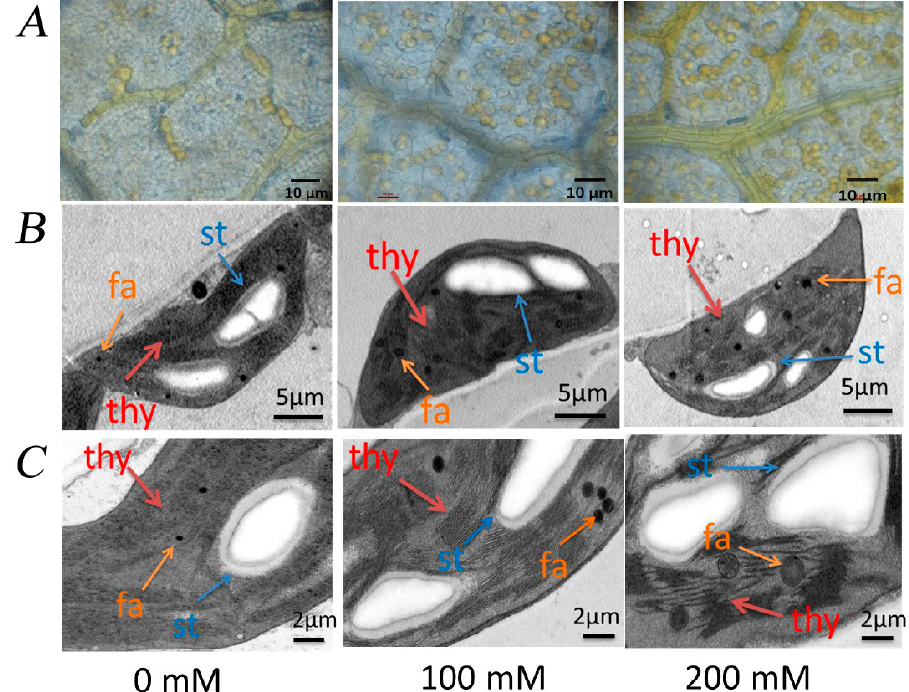
Figure 8. Effect of NaCl stress on the grease content ( A ) and chloroplast structure ( B , C ) of R. pseu- doacacia seedlings. thy: thylakoid; st: starch granule; fa: liposphere. Bars in Figure ( A ) are 10 µm; bars in Figure ( B ) are 5 µm; bars in Figure ( C ) are 2 µm.